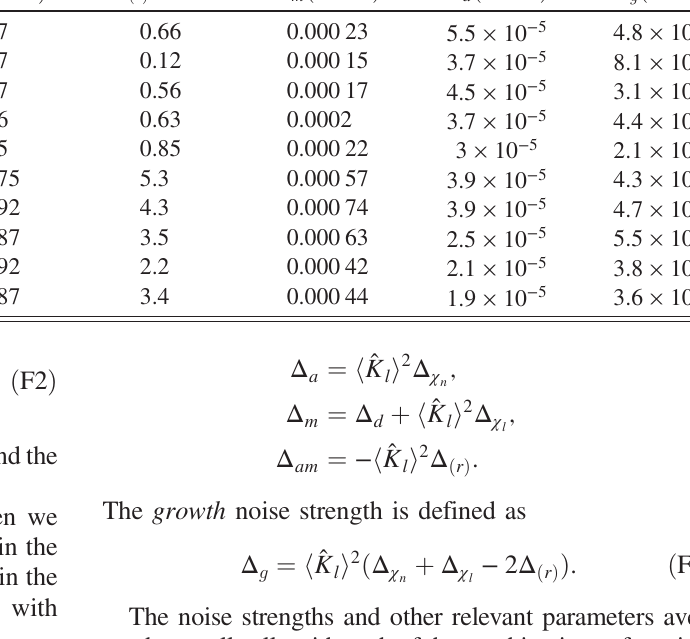
TABLE II. Relevant parameters inferred from the experiments for different promoter strengths and nutrient conditions. These values are calculated by averaging over different mother cells with the same promoter and under the same growth conditions. Conditions